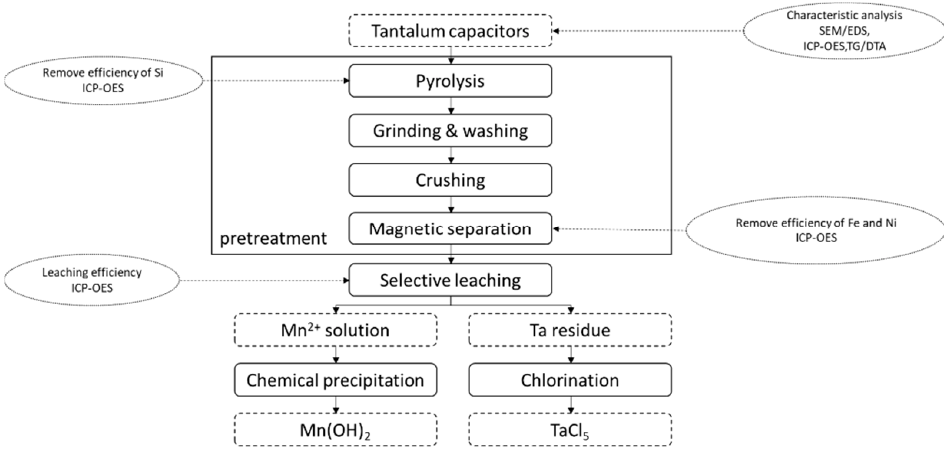
Figure 1. The recovery process of tantalum from EcSETCs. SEM/EDS: multi-function environmental field emission scanning electron microscope with electronic data systems. ICP-OES: inductively coupled plasma optical emission spectrometry. TG/DTA: Thermogravimetric analysis.